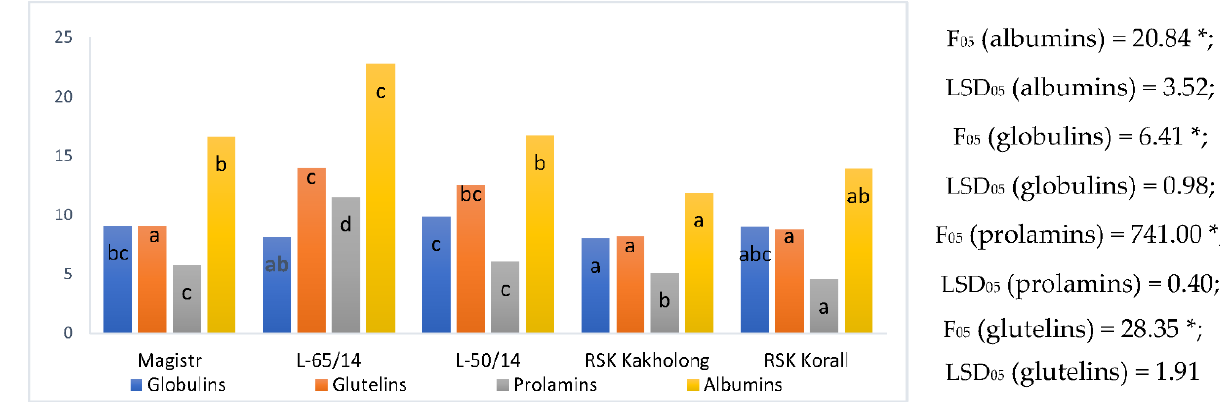
Figure 3. Fractional composition of sorghum, g/100 g of protein. Note: * p ≤ 0.05. Different letters indicate values that differ significantly from each other in the column or the table by comparison with the Dunn’s test.